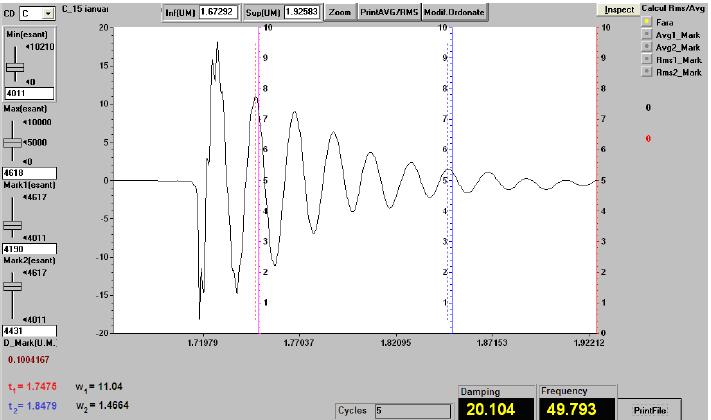
Figure 15. Recording of vibrations (natural frequency and damping factor) in a sample of hybrid resin of type 2, reinforced with the second type of flax fabric, for a free length of 200